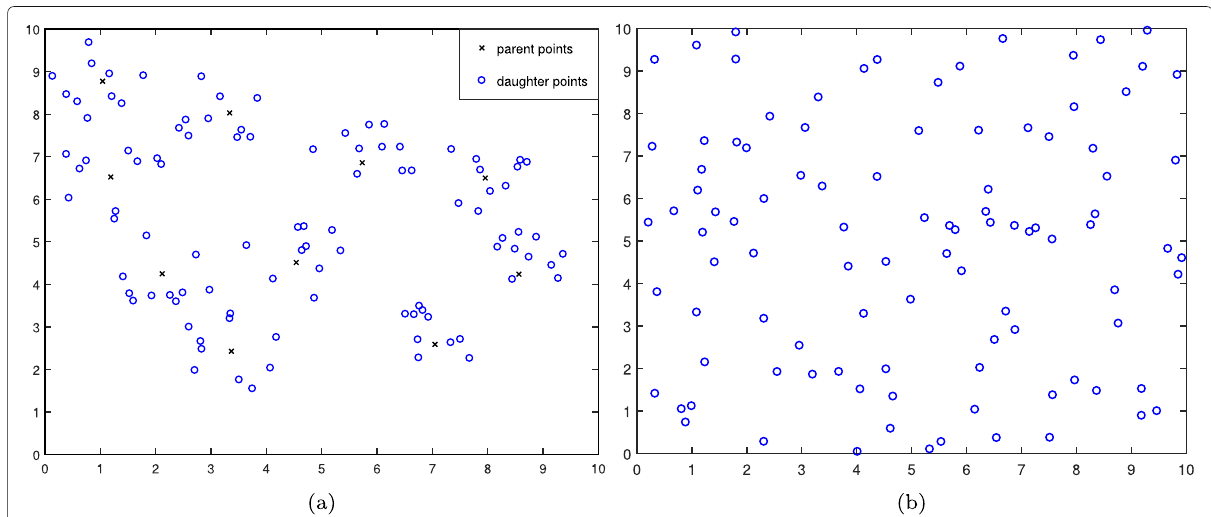
Fig. 1 The PCP model and PPP model with the same average intensity λ = 1 for comparison. a Poisson cluster process ( λ p = 0.1, ¯ c = 10). b Poisson point process ( λ = 1)